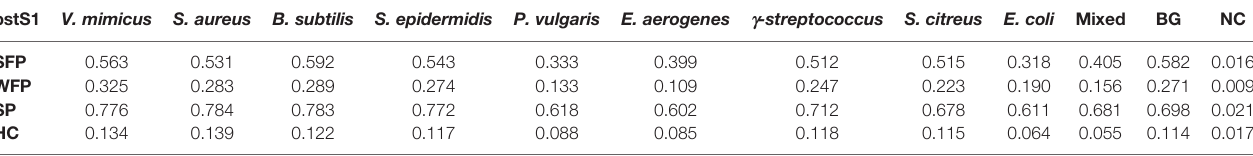
TABLE 1 | The pro fi le of using lysates from various bacteria for sera pre-adsorption to reduce non-speci fi c reactions (for